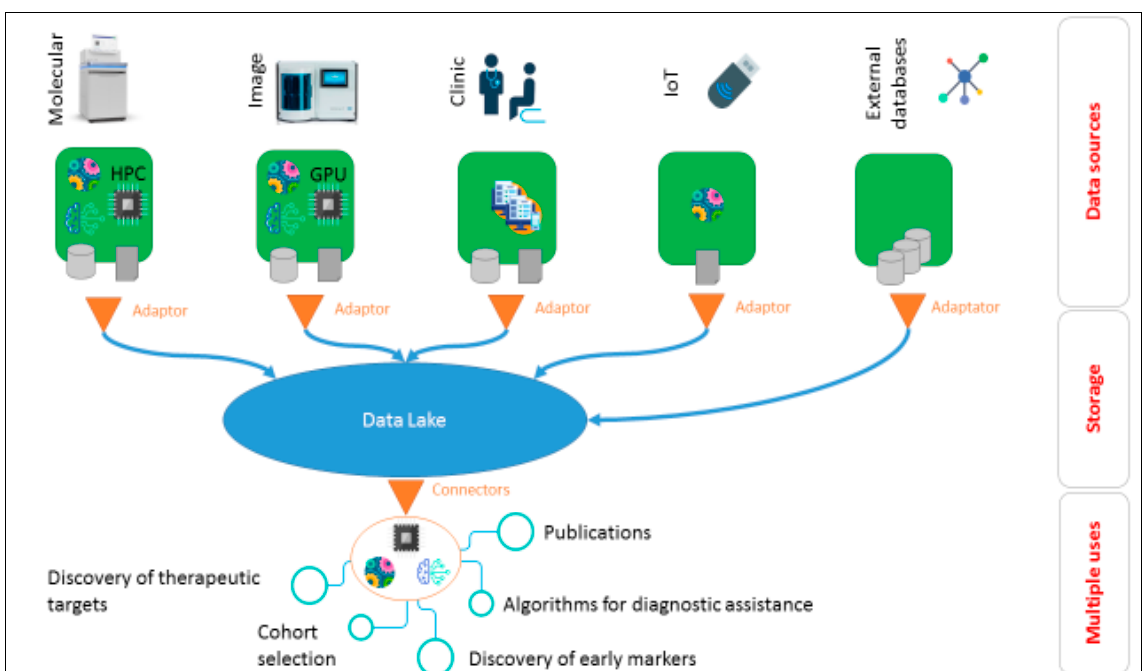
Figure 1. Precision medicine and strategies of data hybridization. IOT: internet of things; GPU: graphic processing unit; HPC: high performance computing. Icons from www.flaticon.com (accessed on 15 May 2020) .